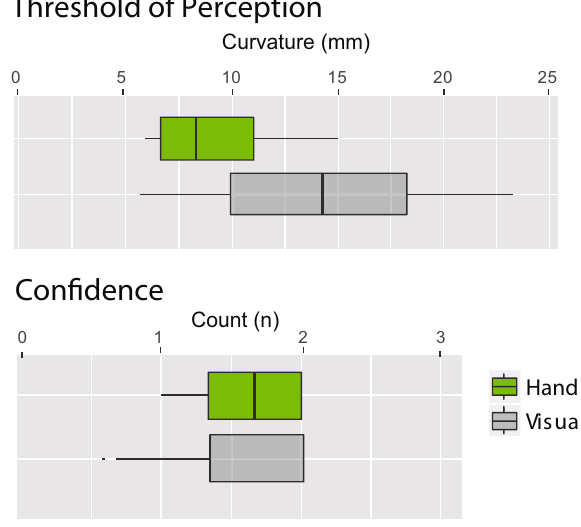
Fig. 7 Results of experiment 2. The threshold of perception ( n = 17) is the point at which the answers to which of the two shapes was curvier started to be random. And on the right, we see the con fi dence that participants had in their assessment. Maximal con fi dence and perception were achieved with their hand touch. Paired Friedman signi fi cant difference across conditions for a threshold of perception ( χ 2 = 12.9, df = 3, p = 0.004), participants reported signi fi cantly higher con fi dences when assessing by touching with their hand than visually ( p < 0.015). For the boxplot: the center line represents the median; box limits represent upper and lower quartiles; whiskers the 1.5x interquartile range; and individual points are the